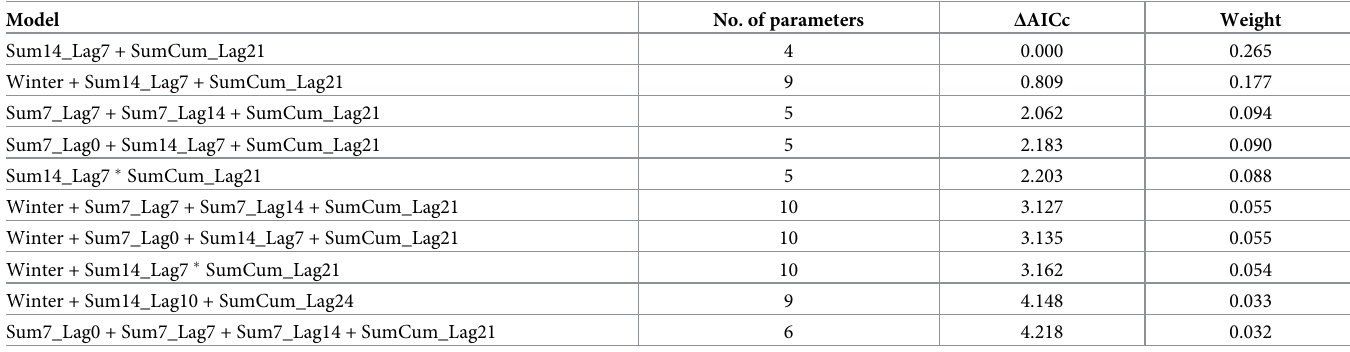
Table 1. Top 10 models for 7-day counts of cold-related manatee carcasses reported in the central-east region based on water temperature. Model